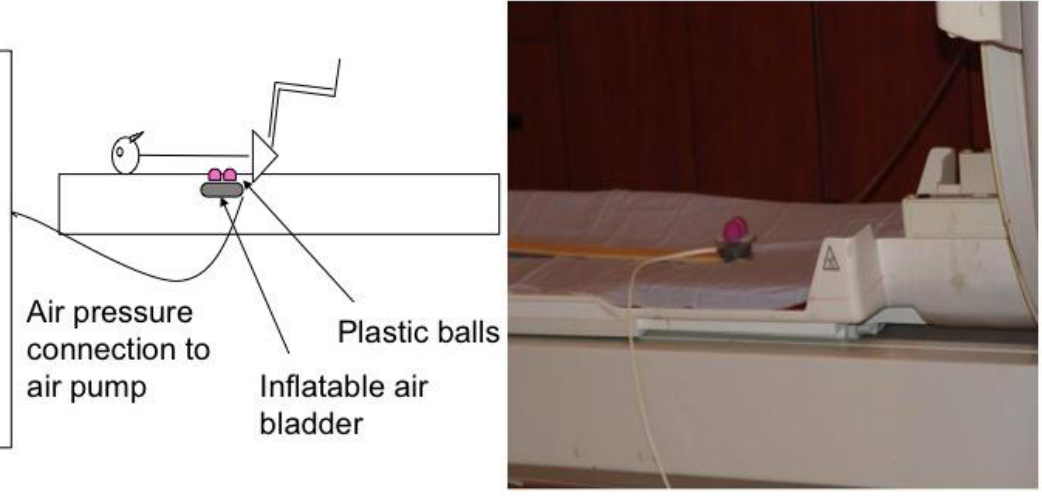
Figure 1. The pressure device.